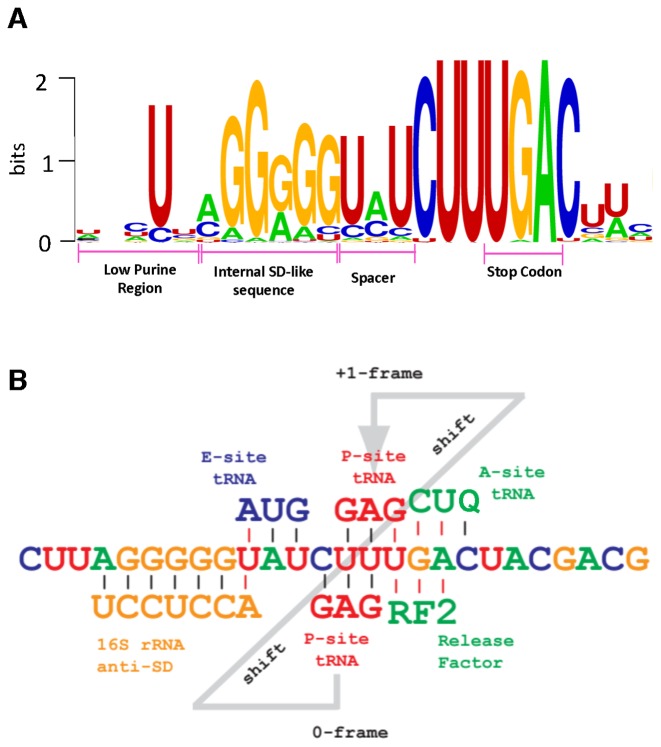
The features of release factor 2 autoregulatory frameshifting are highly conserved in diverse bacteria. The level of the release factor for the underlined ORF1 stop codon UGA(C) governs the efficiency with which the anticodon paired to the 5′ adjacent codon, CUU, shifts +1 to pair with UUU permitting continued translation to synthesize release factor 2. The frameshift stimulatory internal Shine Dalgarno (SD) sequence is preceeded by sequence unable to pair with the anti-Shine Dalgarno sequence of translating ribosomes, permitting availability of the anti-Shine Dalgarno to form the correctly positioned frameshift stimulatory hybrid with mRNA. The figure was generated with Weblogo3 (815) using RF2 frameshift sites obtained from ARFA (348).